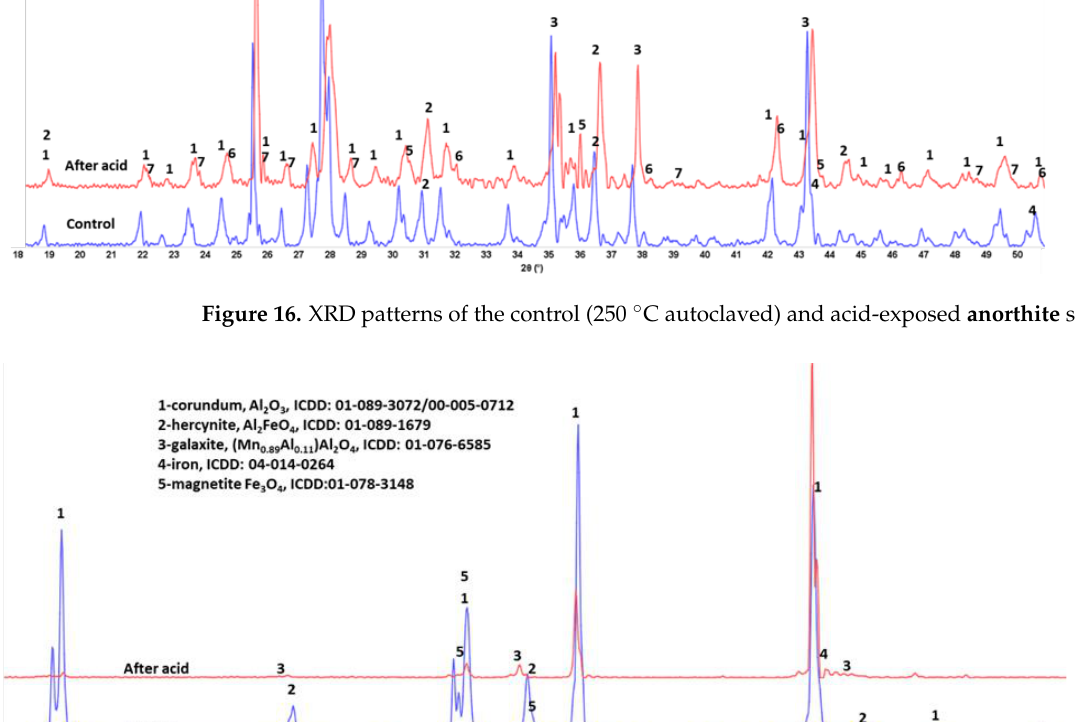
Figure 17. XRD patterns of the control (250 °C autoclaved) and acid-exposed aluminum oxide samples.